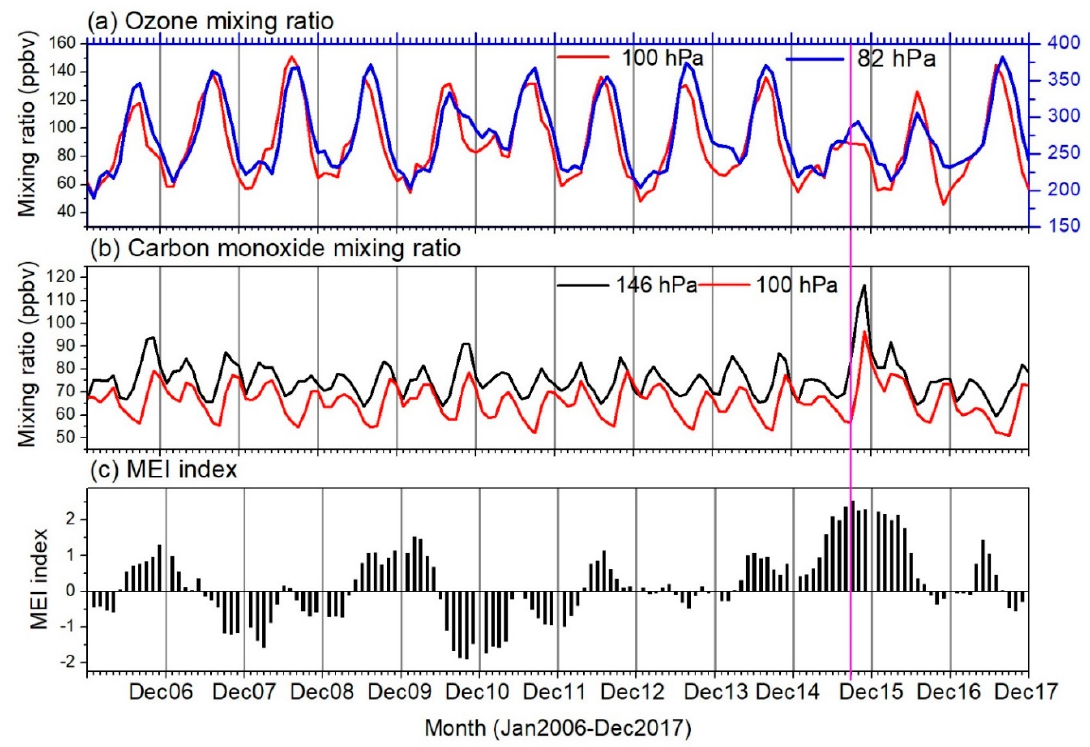
Figure 1. Time series of observed monthly mean ( a ) ozone at 100 and 82 hPa, ( b ) carbon monoxide at 100 and 146 hPa and ( c ) Multivariate ENSO Index (MEI) from January 2006 to December 2017.